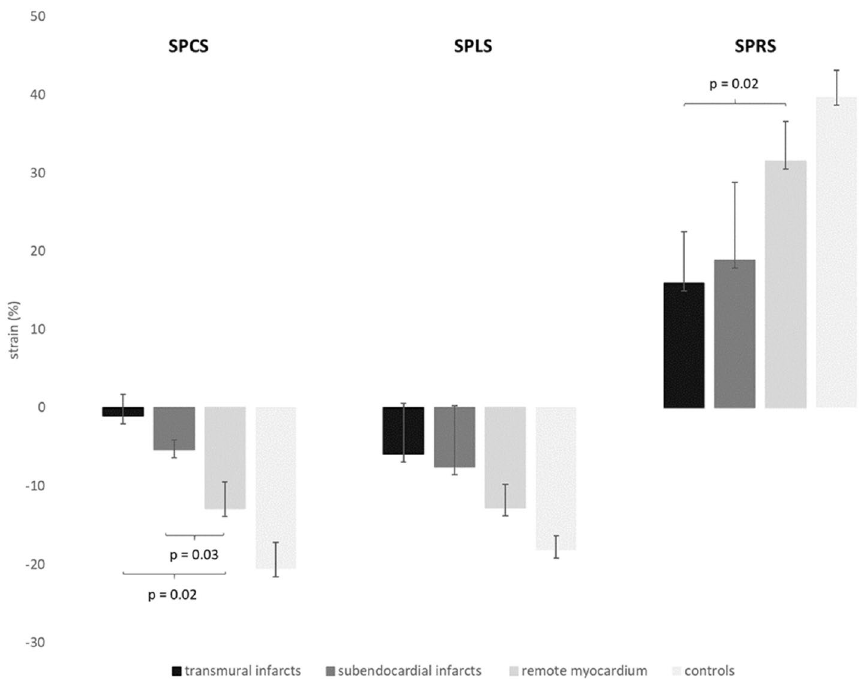
Figure 3. Segmental strain values in patients and healthy controls. Brackets signalize significantly different strain values between groups. Significance between infarcted segments and controls are presumed and thus not marked. SPCS segmental peak circumferential strain, SPLS segmental peak longitudinal strain, SPRS segmental peak radial strain.